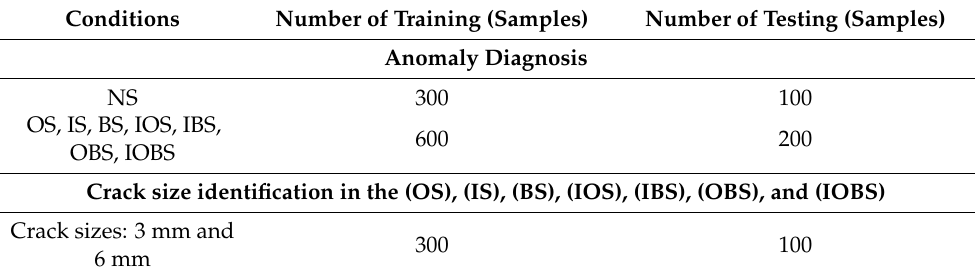
Figure 11. Residual RMS signal using sliding digital twin. Table 3. The number of samples for training and testing for crack diagnosis and crack size identification.